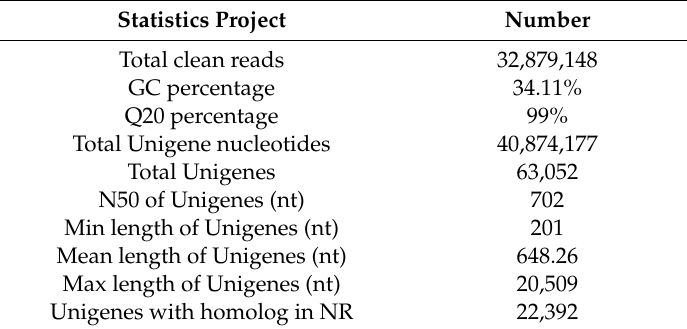
Table 1. Summary of Cacopsylla chinensis transcriptome assembly.